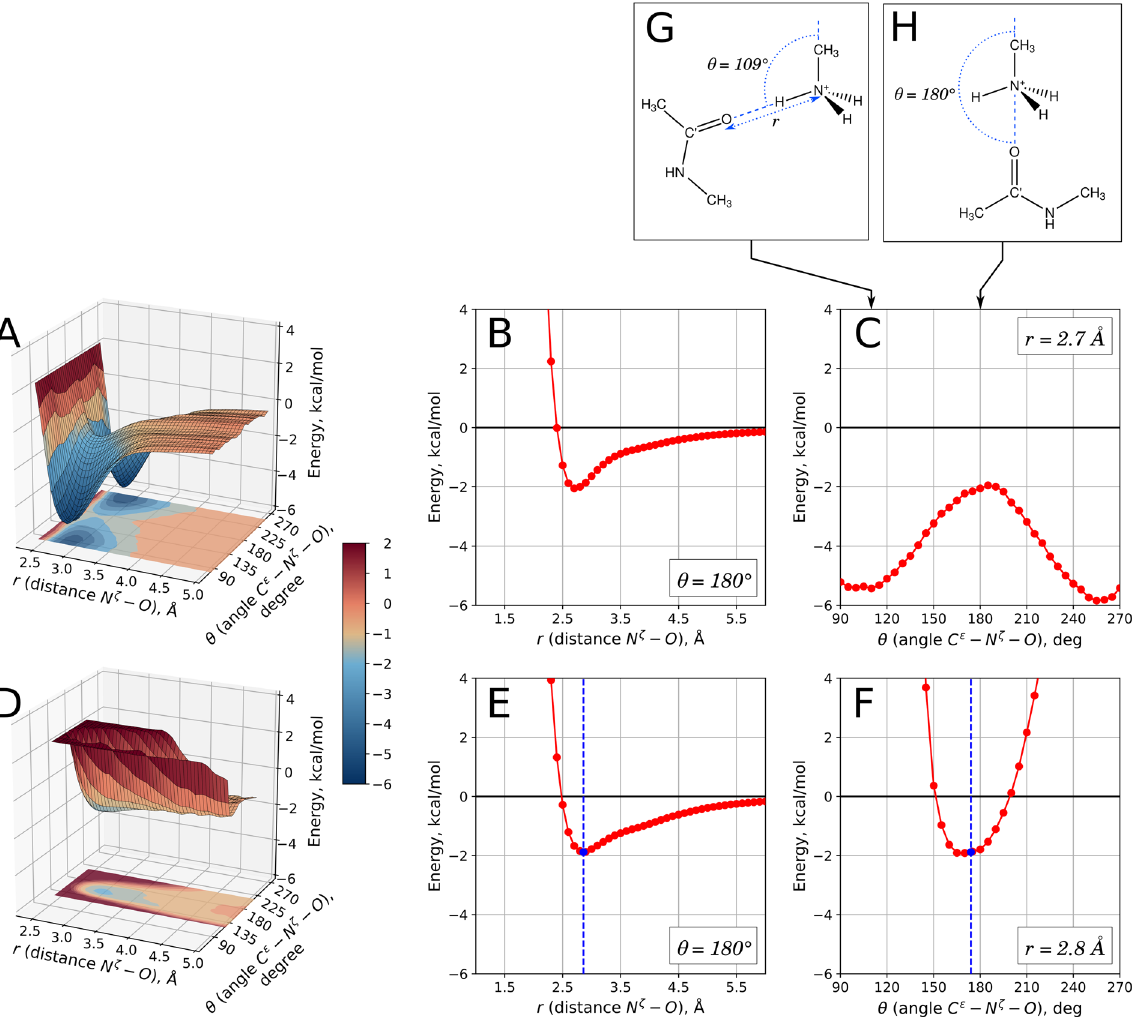
Figure 2. DFT energy scans for two models representative of the linear interaction between lysine NH 3 + group and carbonyl. ( A – C ) Calculations using 2-molecule model consisting of methylammonium ion and N-methylacetamide. The model is illustrated in panels G (hydrogen bond arrangement) and H (linear arrangement). Note that the minimum at θ = 109° in panel C offers a more accurate estimation of energy for NH 3 + – carbonyl hydrogen bond than symmetric minimum at θ = 360°–109° because the latter is additionally enhanced by a favorable packing of the methyl groups. ( D – F ) Calculations using 5-molecule model, based on PDB ID 4RLZ. The model is as shown in Fig. 1A, with all “hanging” bonds capped by protons. Blue vertical line indicates the geometry found in this PDB structure and blue circle represents the respective calculated